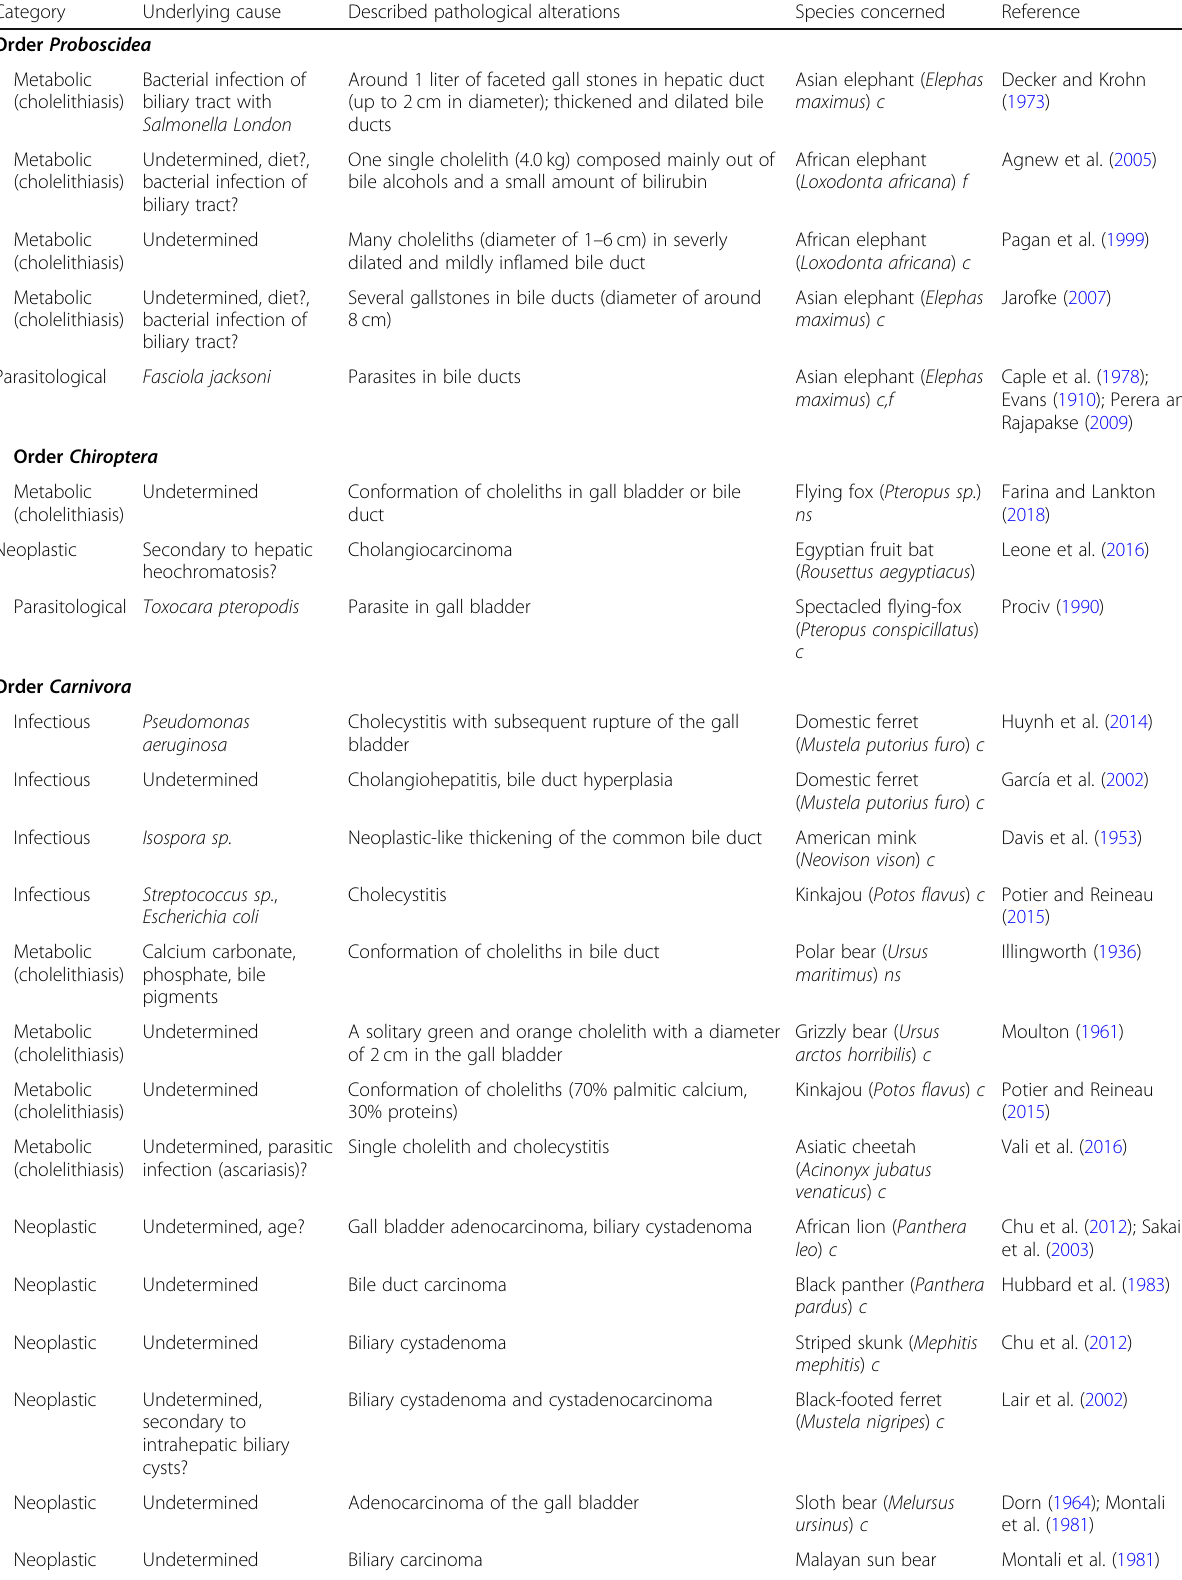
Table 1 Reported pathologies of the extrahepatic biliary tract in mammalian exotic pets and wildlife species